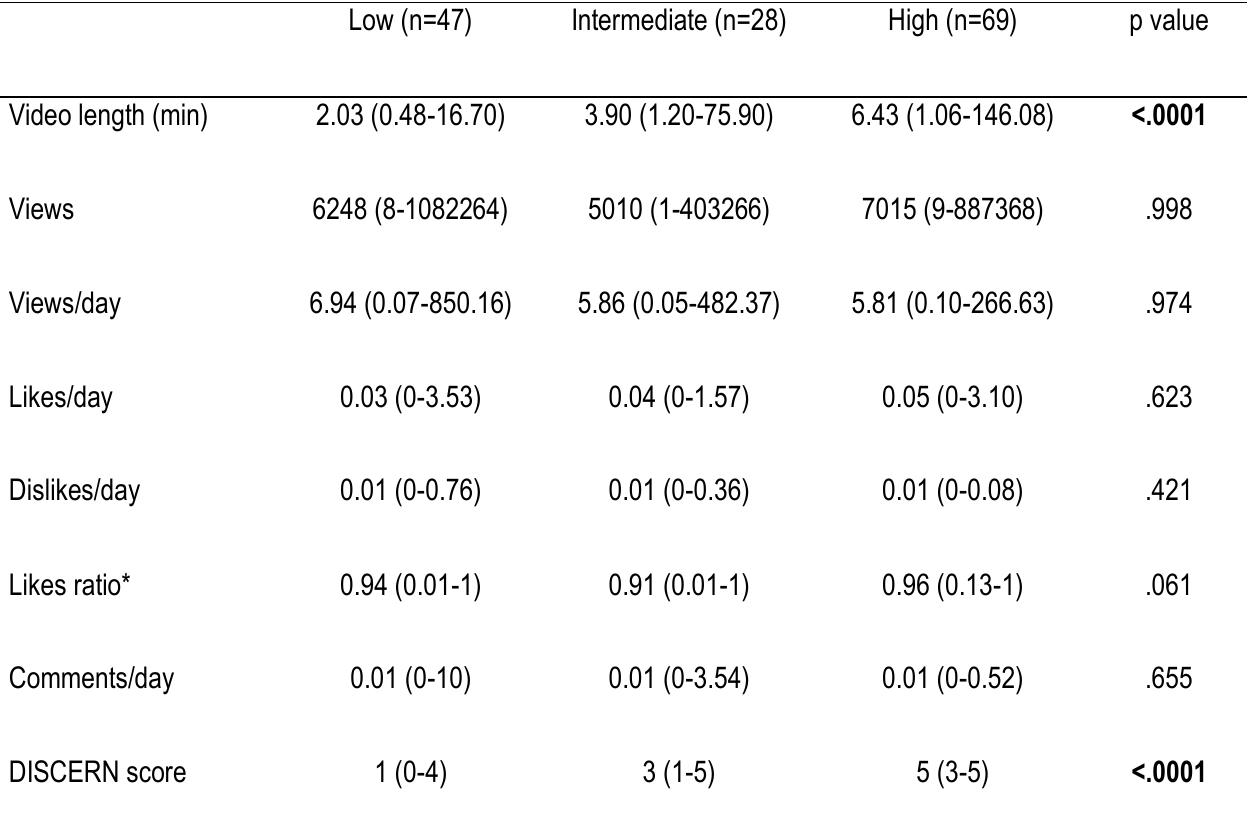
Table 4. Analysis of video characteristics according to GQS quality, median